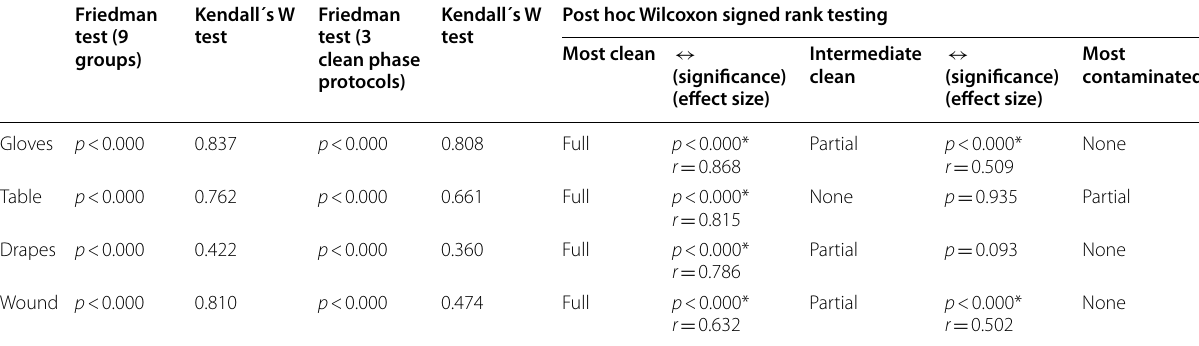
Table 1 Statistical analysis and comparison of the results of the three different clean phase protocols Friedman test (9 groups)